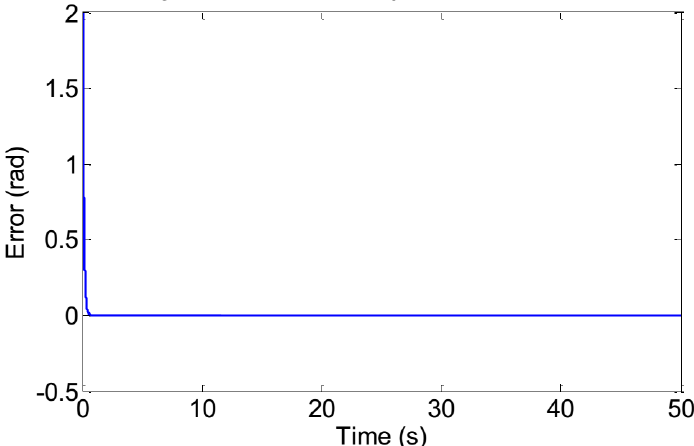
Figure 5. The magnitude of the second arm joint position tracking error.